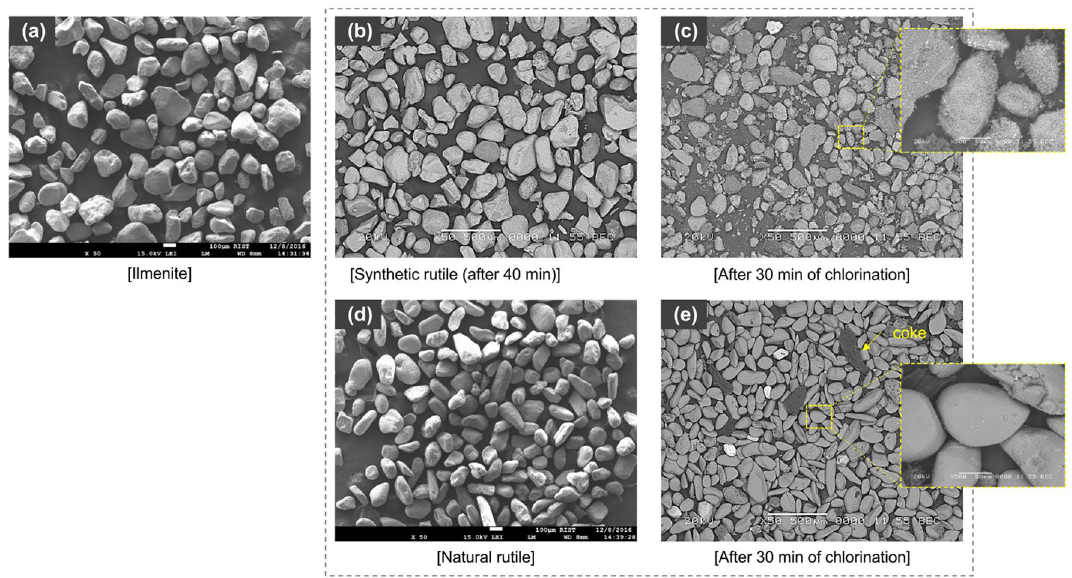
Figure 4. SEM images of surface morphology for ( a ) raw ilmenite and ( b ) ilmenite chlorinated for 40 min ( c ) synthetic rutile chlorinated for 30 min ( d ) raw natural rutile ( e ) natural rutile chlorinated for 30